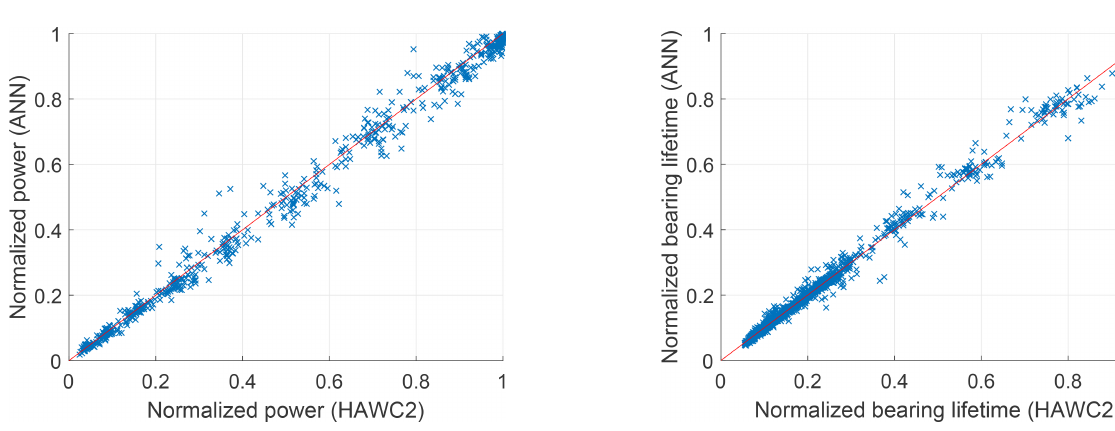
Figure 8. Normalized electrical power P estimated by ANN on test set with respect to normalized power simulated using HAWC2.